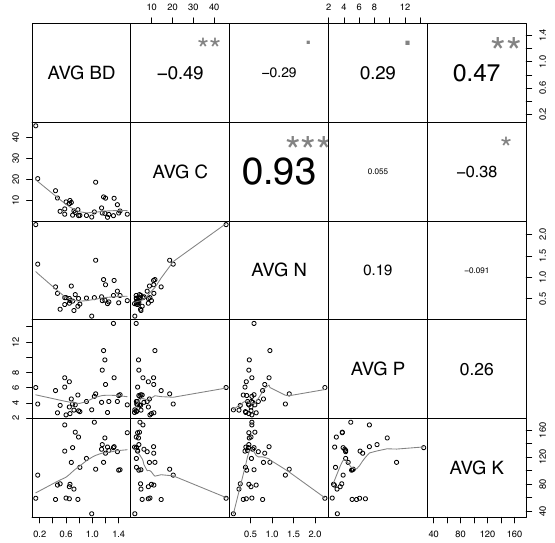
Figure 8. Correlations between AVG BD [g/cm 3 ], average carbon (AVG C) [%], average nitrogen (AVG N) [%], average exchangeable phosphorus (AVG P) [ppm] and average exchangeable potassium (AVG K) [ppm] for the 0-15 cm depth